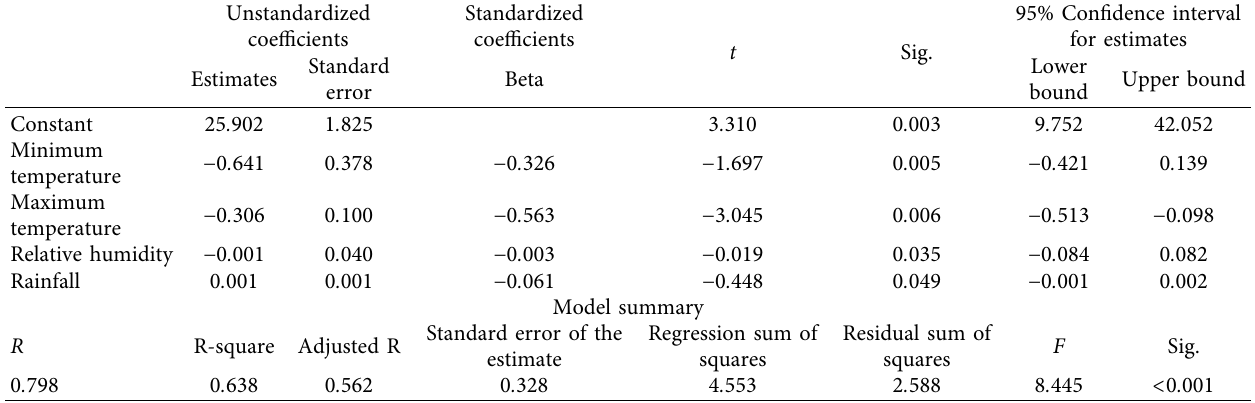
Table 2: Multiple linear regression output of maize yield under climatic